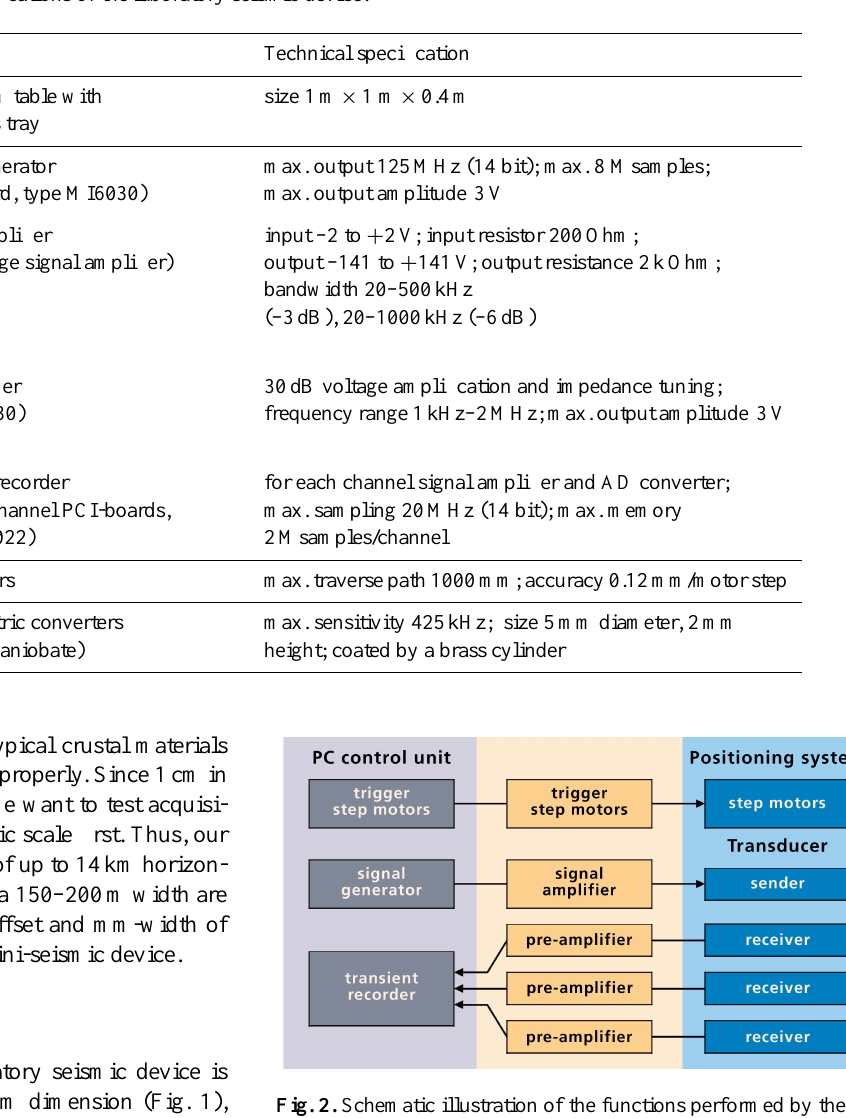
Table 1. Components and technical specifications of the laboratory seismic device.